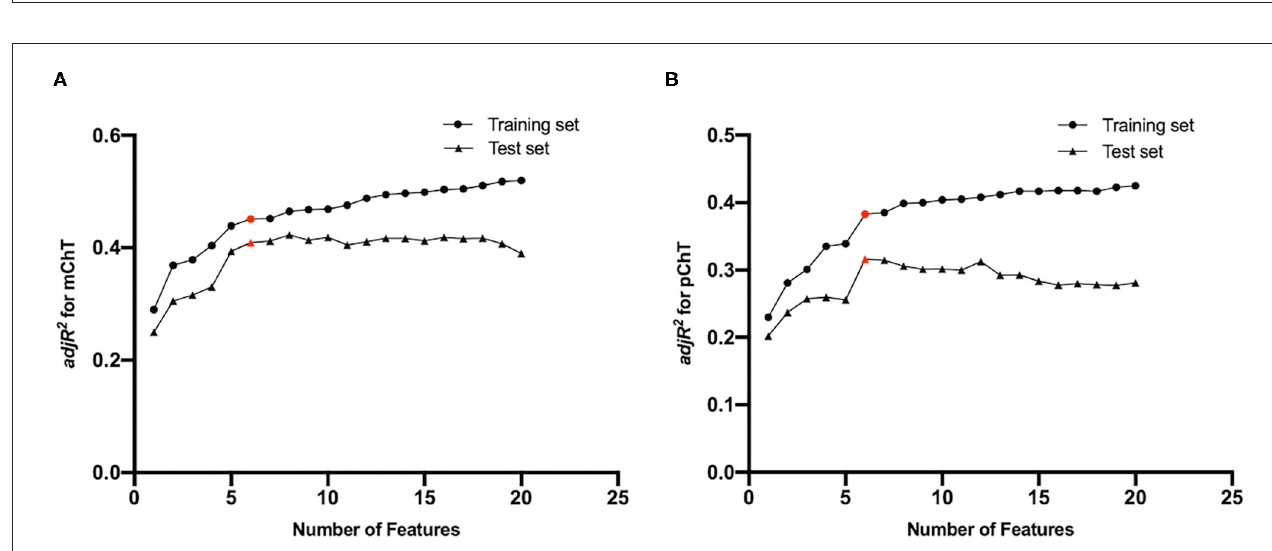
FIGURE 2 | Feature selection results by LASSO regression for (A) macular choroidal thickness (mChT) and (B) peripapillary choroidal thickness (pChT). As the number of selected features increased, adjusted coefficients of determination ( adjR 2 ) in the training and test sets fluctuated. Red points represent selected feature sets.